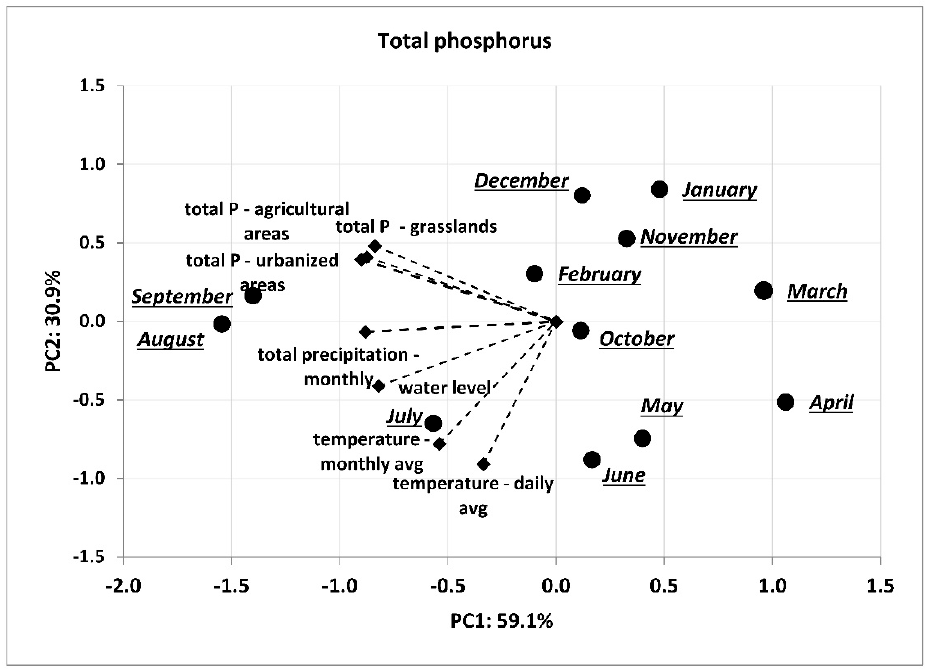
Figure 8. PCA analysis for the relationships between: catchment area land use, weather conditions and total phosphorus concentration in the Utrata River.